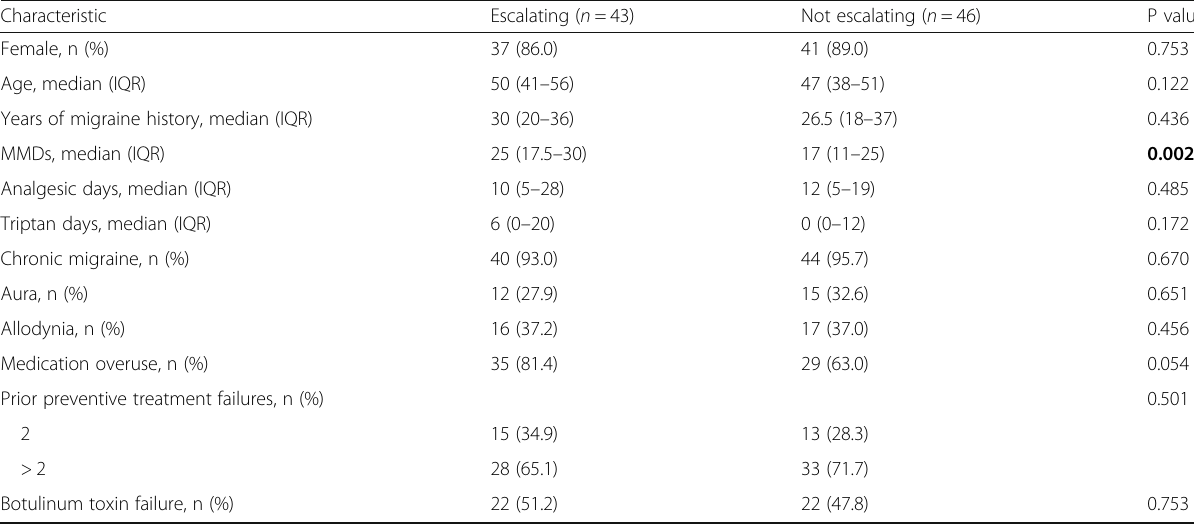
Table 2 Characteristics of patients escalating vs those not escalating the dose of erenumab during the treatment Characteristic Escalating ( n = 43) Not escalating ( n =